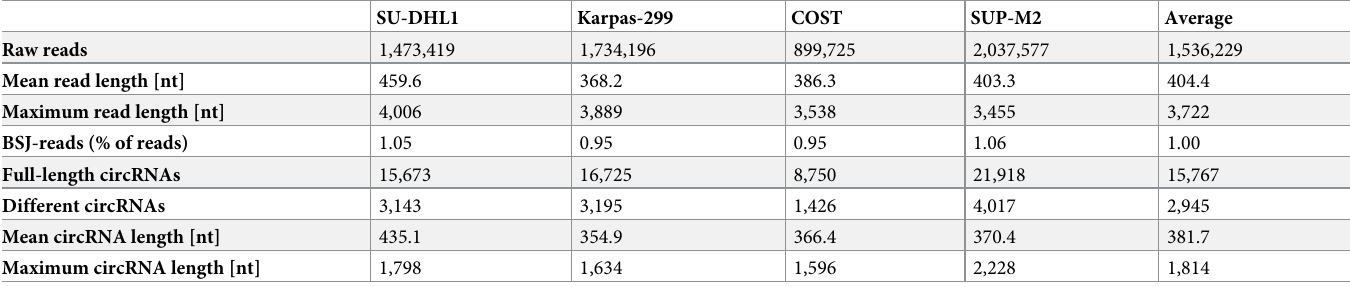
Table 2. Sequencing results obtained with one MinION flow cell. circRNA-enriched libraries from 4 anaplastic large-cell lymphoma cell lines were sequenced by Oxford Nanopore. Calculations are based on the passed reads and the circRNA analysis was performed with CIRI-Long. BSJ, back-splice